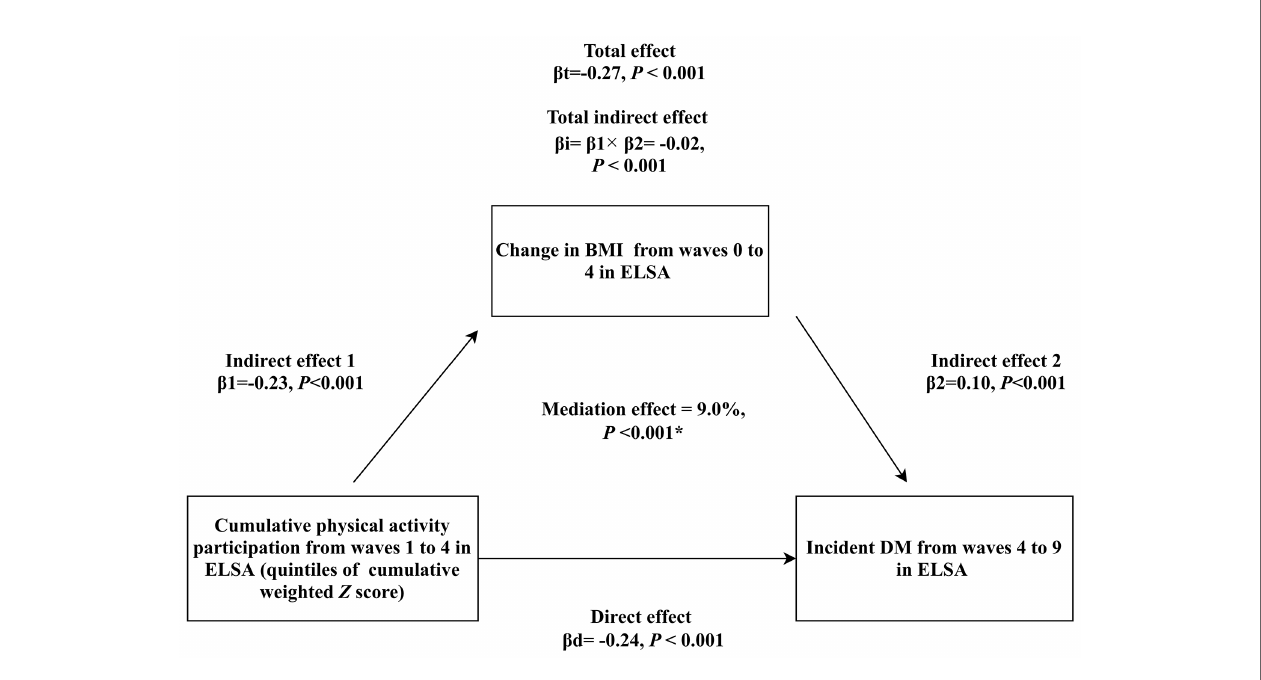
FIGURE 5 | Mediation analysis assessing the mediating role of change in BMI from waves 0 to 4 in the association of cumulative weighted global physical activity Z score quintiles on subsequent incident DM. b d: coef fi cient for direct association of cumulative weighted global physical activity Z score quintiles on subsequent incident DM. b i: coef fi cient for total indirect association of change in BMI. b t: coef fi cient for total association of cumulative weighted global physical activity Z score quintiles on subsequent incident DM. *: adjusted covariates included sex, age, ethnicity, education, cohabitation status, mobility status, current smoking, alcohol consumption, BMI in wave 0, depressive symptoms, hypertension, prediabetes status, stroke, cardiovascular diseases, chronic lung diseases and